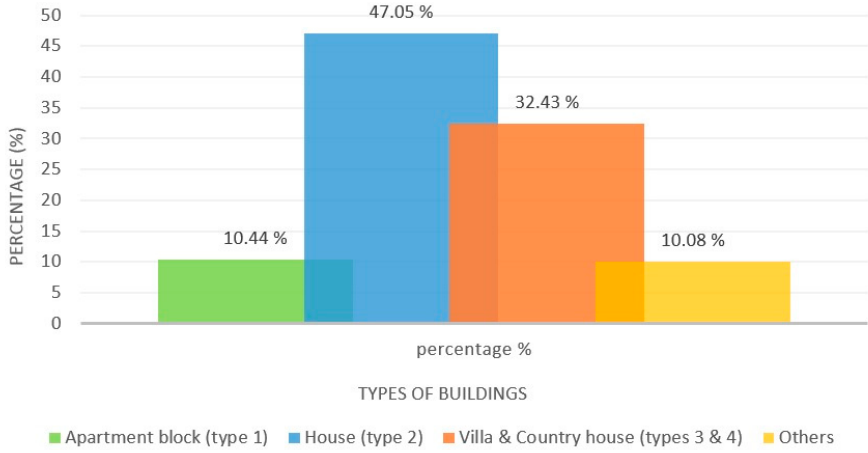
Figure 3. Percentages of different buildings based on data from [14,15].